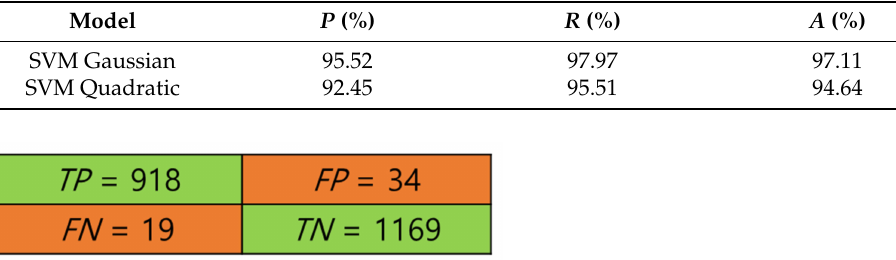
Figure 9. Confusion matrix of the Gaussian kernel SVM model.